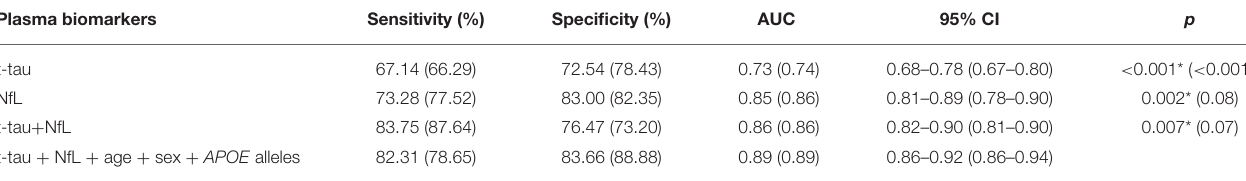
Performance of plasma biomarkers for probable AD diagnosis, including the sensitivity, specificity, AUC, and 95% CI. The values in brackets refer to the results of diagnostic efficacy analysis on a subset of patients who underwent lumbar puncture. The p-value is obtained by comparing each model with the combined model incorporating t-tau, NfL, age, sex, and APOE alleles through the Delong test. Age here refers to the age at diagnosis. AD, Alzheimer’s disease; AUC, under the curve; CI, confidence interval; NfL, neurofilament light chain; t-tau, total tau. * The difference of the correlations between these biomarkers is statistically significant (p < 0.05).